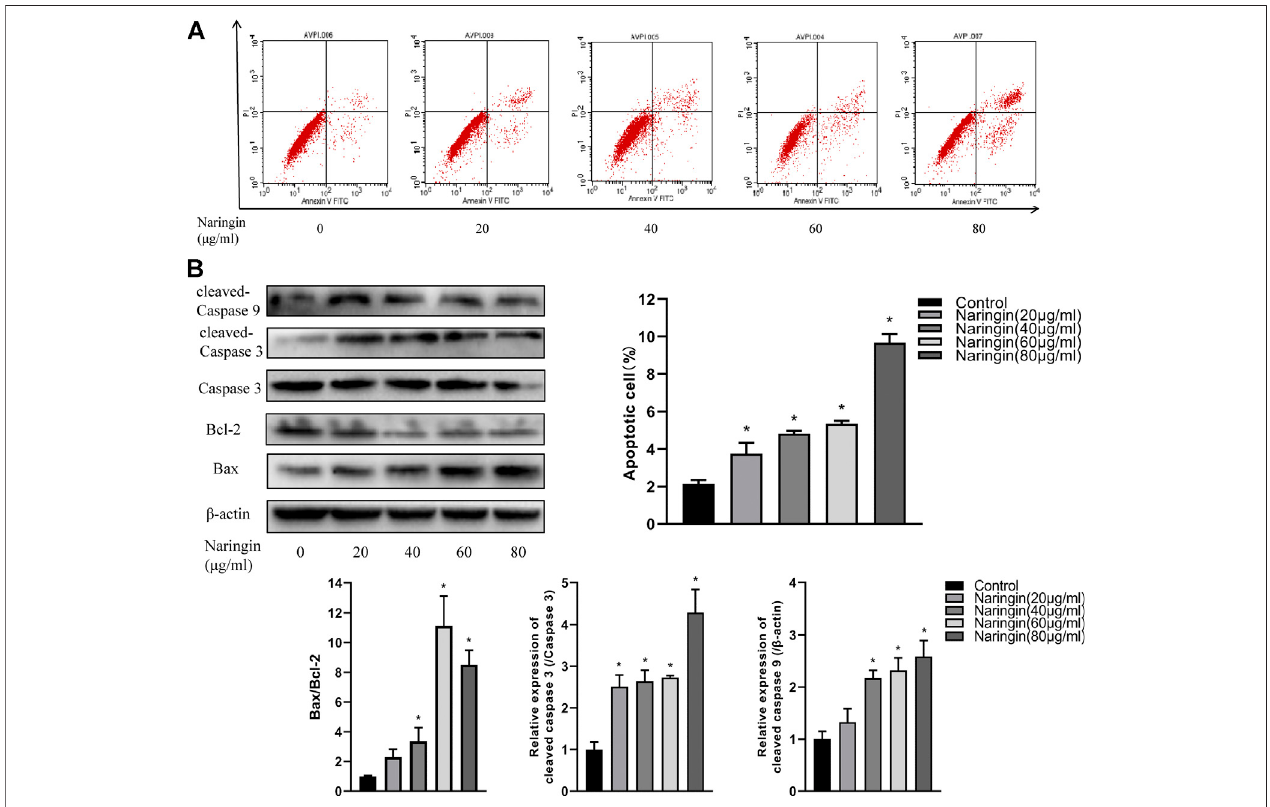
FIGURE 8 | Naringin induces apoptosis of RA-FLS in a dose-dependent manner. (A) Representative fl ow cytometric plots and statistical graph. (B) Effect of naringin on apoptosis-related proteins expression via Western blot analysis and statistical graphs. * p < 0.05. Each experiment was repeated for three times in different